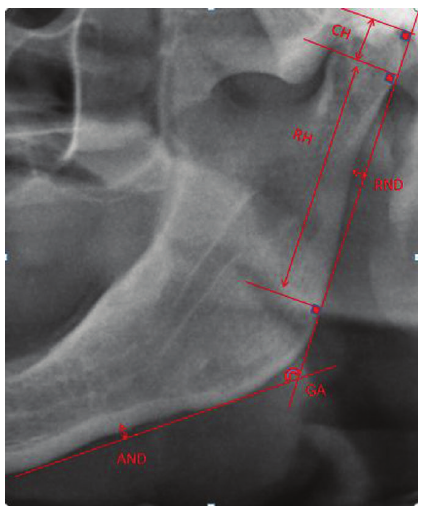
Figure 1: Measuring method used for the gonial angle, ramus height, condylar height, antegonial notch depth, and ramal notch depth on panoramic